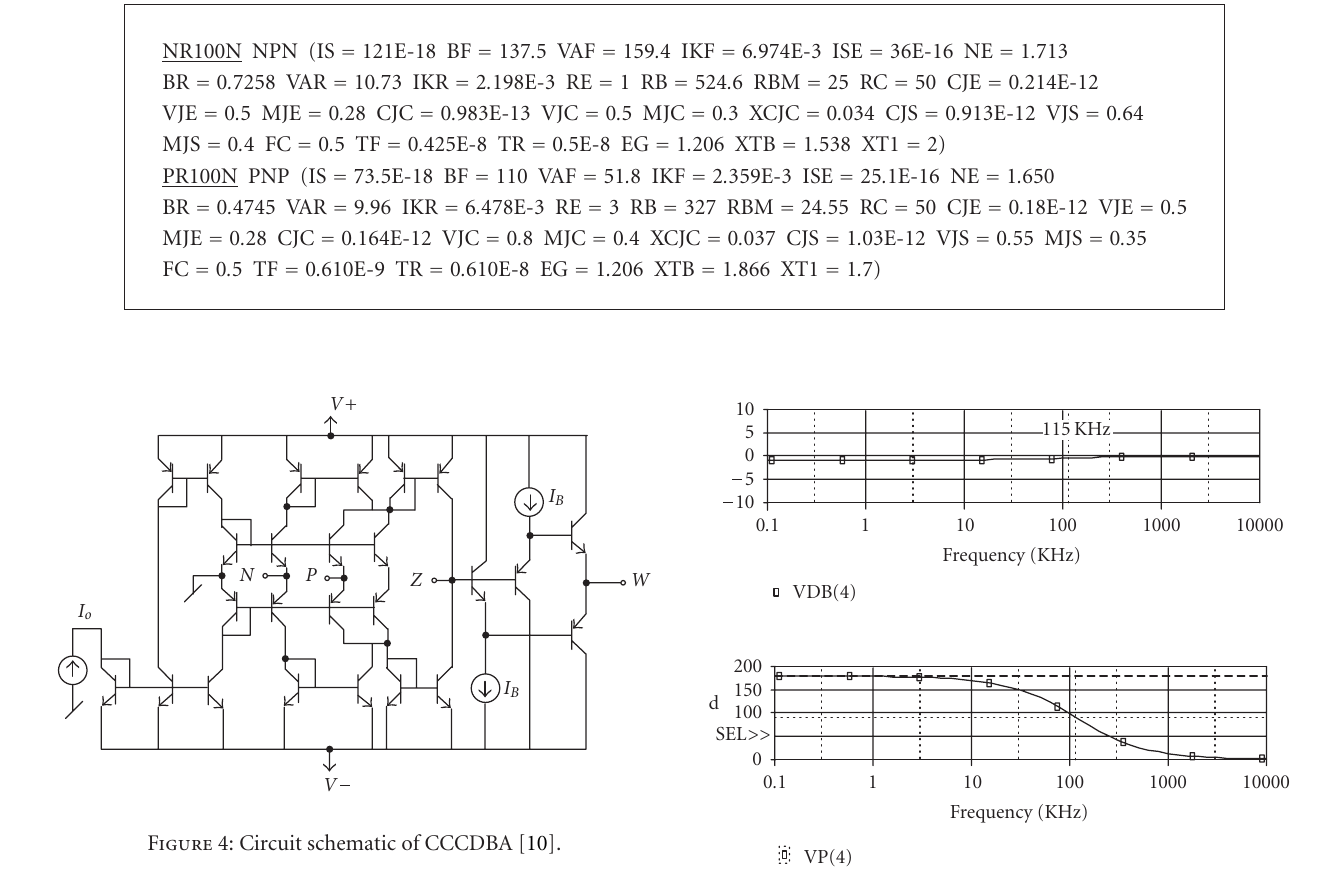
Table 1: NR100N and PR100N transistor parameters.